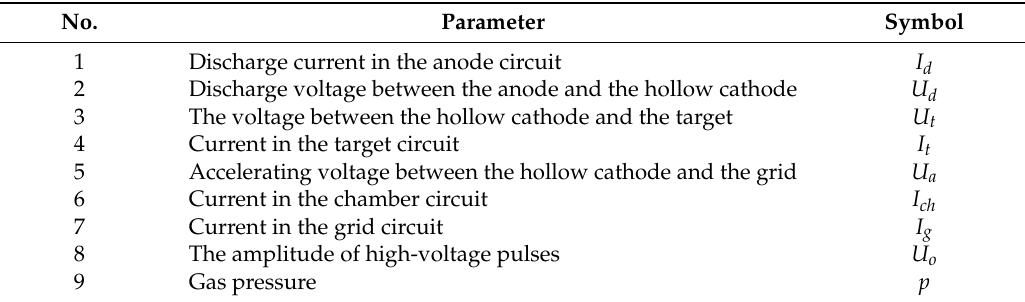
Table 1. Main controlled